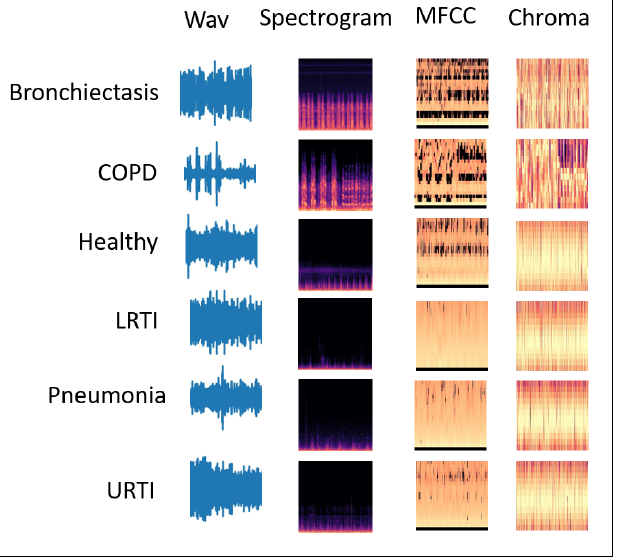
Figure 2. Lung Sound Features: (1) Wav (2) Spectrogram (3) MFCC (4)